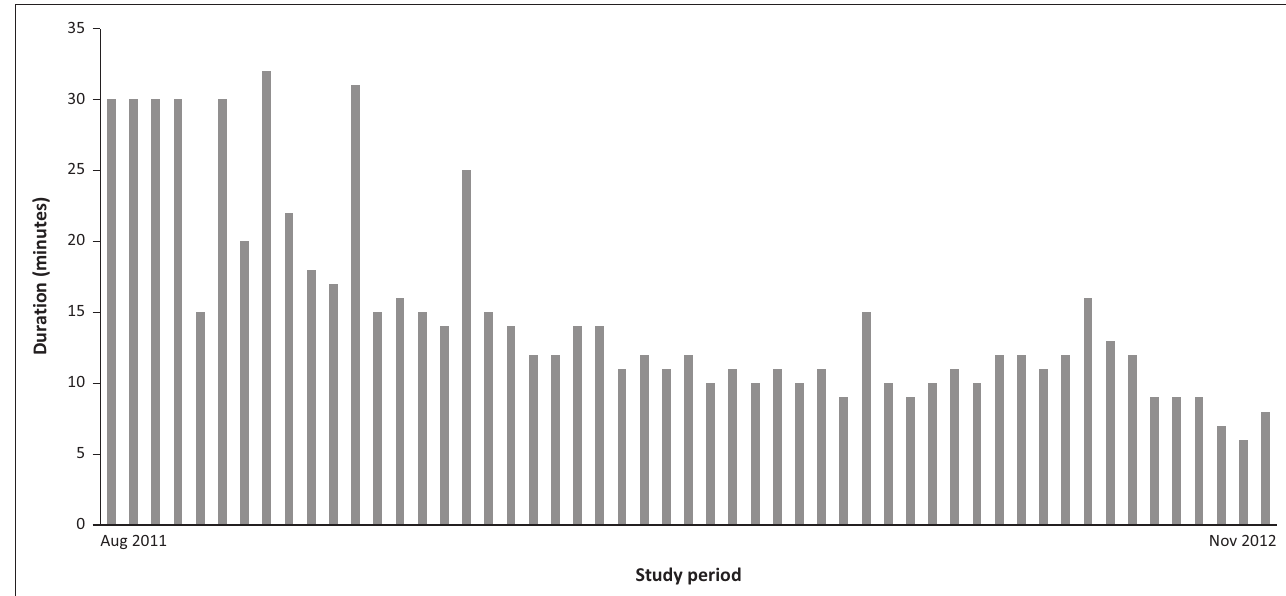
FIGURE 1: Duration of flexible endoscopic